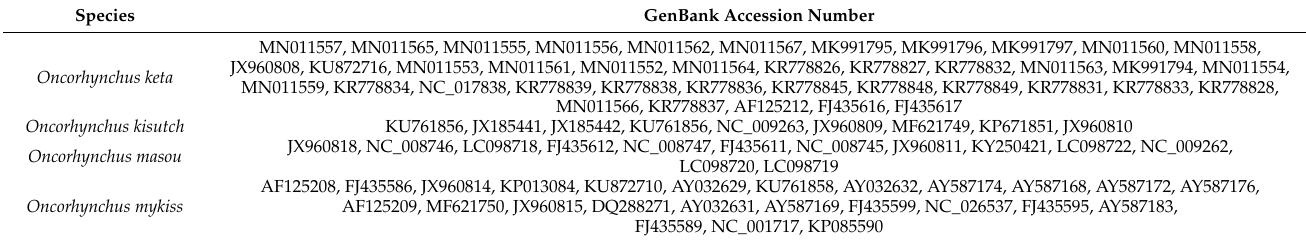
Table A1. Haplotype sequences retrieved from GenBank to construct a consensus sequence for designing primers and